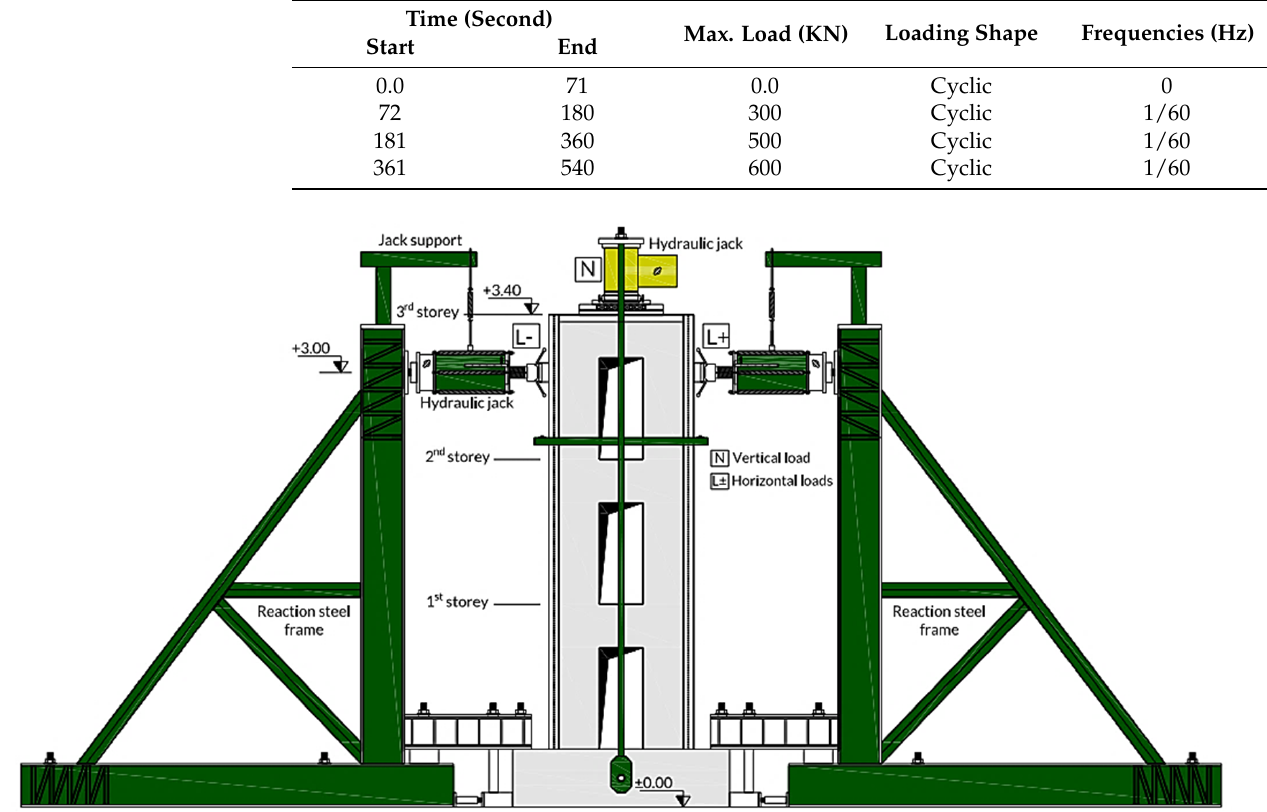
Figure 2. Cyclic loading arrangement.